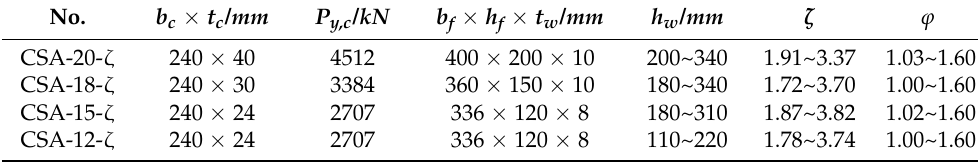
Table 3. Key geometric dimensions and results of the various components of